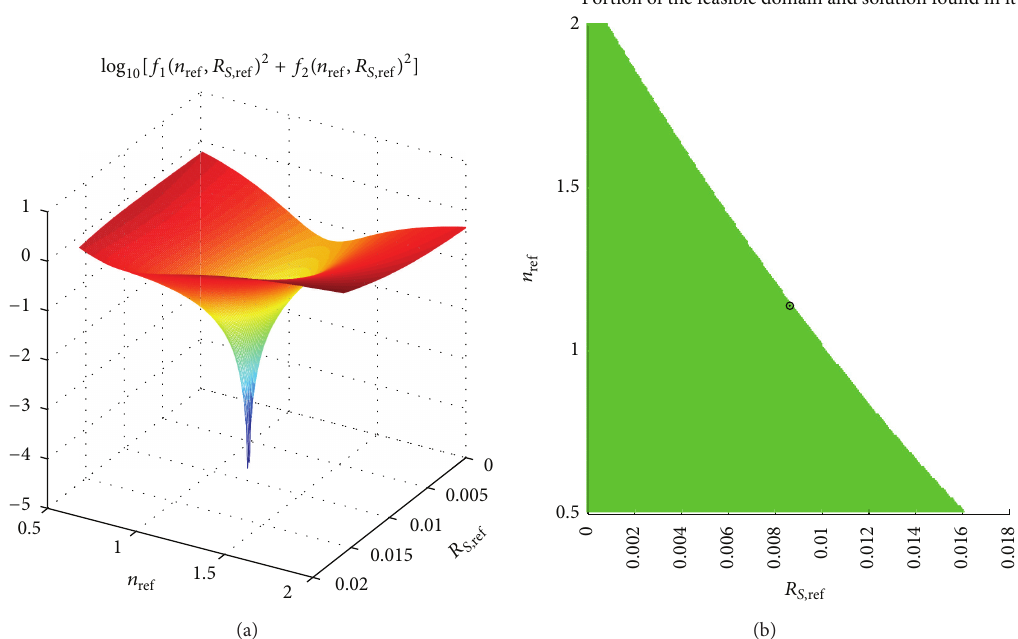
Figure 3: Graph of the functional (25) and feasible domain for the Sharp NT175 panel (mono-Si technology). A unique physical solution